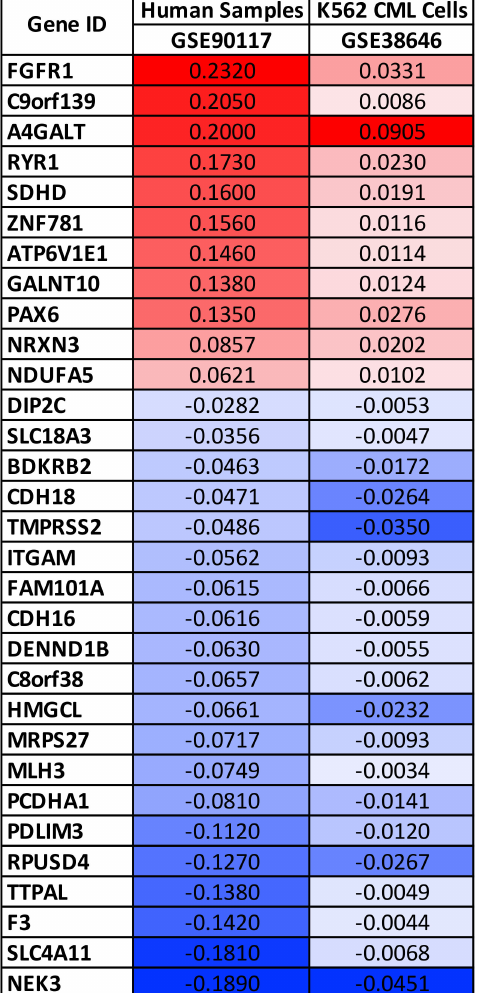
Figure 2. Differential gene methylation status after pesticide exposure. The fold change values are expressed as log2 of fold change. Hyper-methylated genes are highlighted with red scale boxes while hypo-methylated genes are highlighted with blue scale